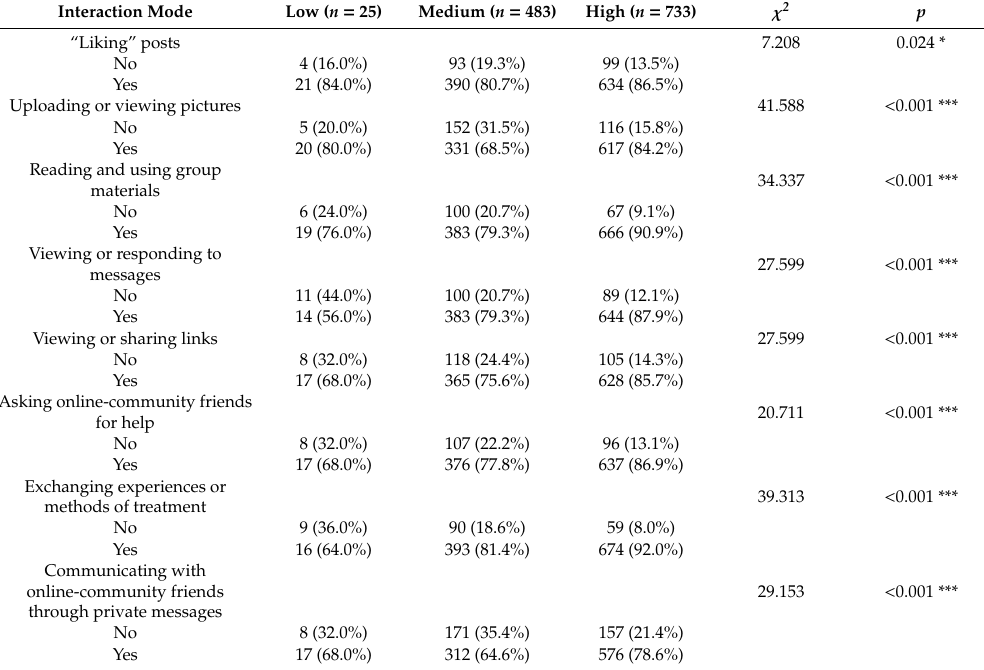
Table 2. The cross analysis for self-e ffi cacy and online group interaction mode of the